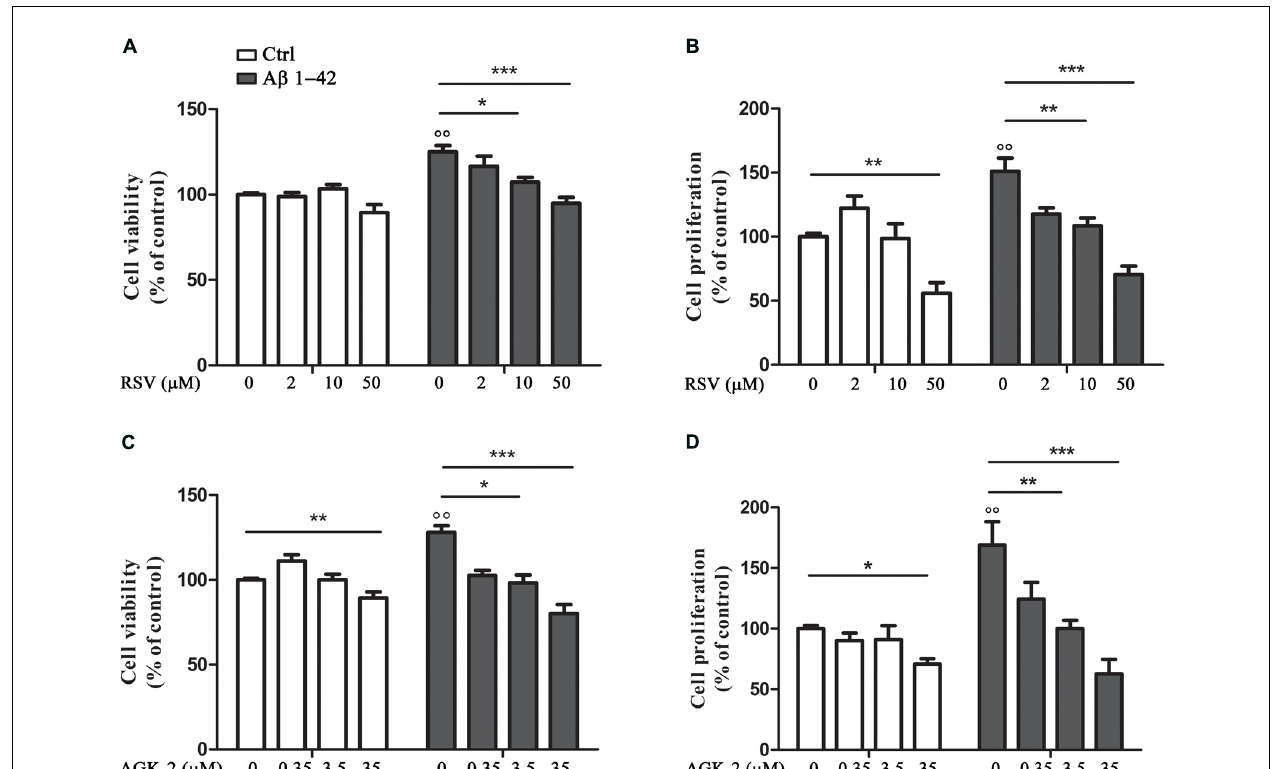
evaluated by trypan blu assay (B,D) . Results are expressed as cell viability-fold increase versus unchallenged (open bars) or A β -challenged cells (black bars). Results are the mean ± SEM of four experiments in triplicate. Statistical analysis was performed by one-way ANOVA followed by Bonferroni multiple comparison test. p < 0.01 A β -challenged versus unchallenged cells; * p < 0.05; ** p < 0.01; *** p < 0.001 for multiple comparison among